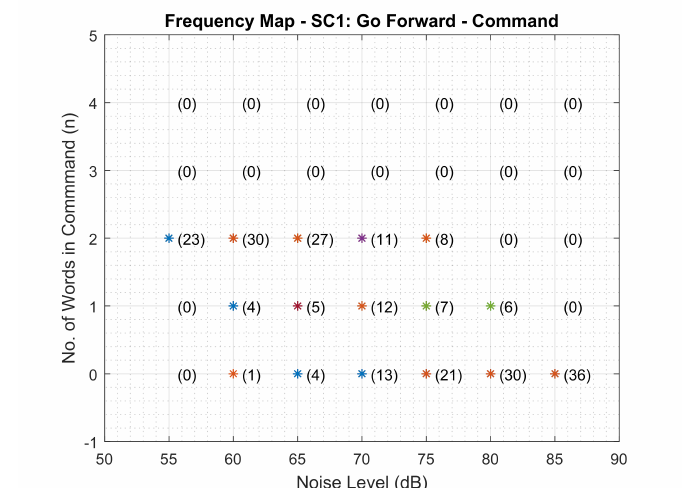
Figure 2. The first speech command (SC1) frequency map.